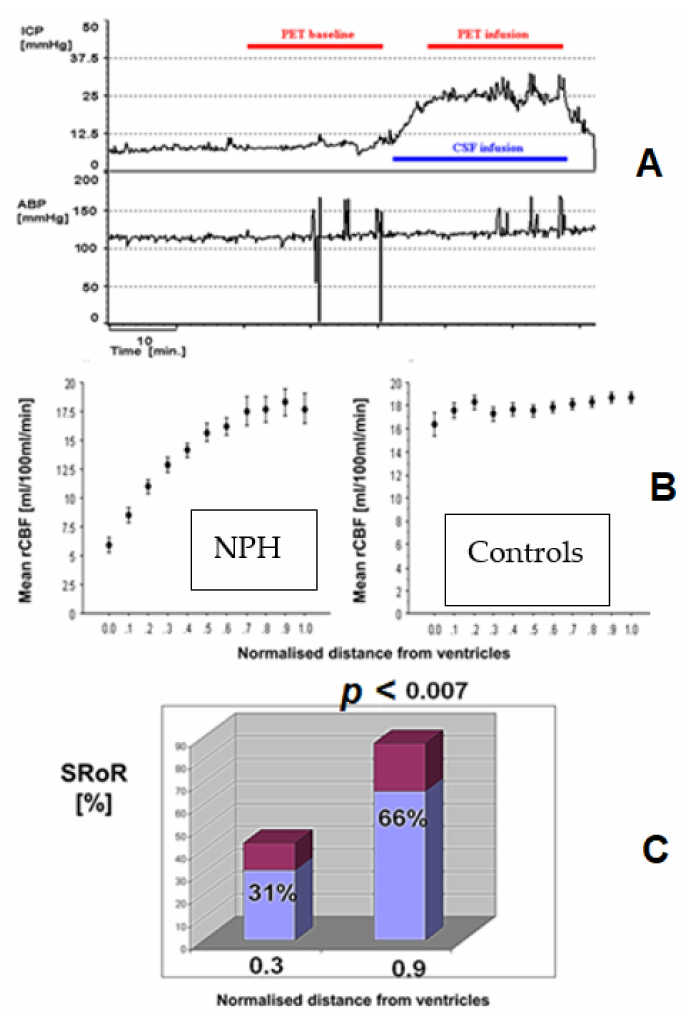
Figure 10. Regional cerebral blood flow and autoregulation in hydrocephalus: relationship with distance from ventricles. ( A ): Demonstration of methodology from our previous investigation of cerebral blood flow (CBF) using PET H2O whilst performing a simultaneous infusion test to monitor ICP. ( B ): PET study at baseline for recordings of CBF (before infusion test). The mean regional CBF (rCBF) in NPH ( left ) was significantly reduced in proximity to the ventricles compared to normal, aged-matched controls. ( C ): ICP monitoring allowed for calculation of the static rate of autoregulation (SRoR), which demonstrated that autoregulation of CBF is similarly significantly impaired in NPH at the regions in close relationship with the ventricles. SRoR is derived from the change in cerebral perfusion (Mean Arterial Blood pressure–ICP) and CBF during infusion. SRoR 100% indicates ideal autoregulation and 0% absent autoregulation. ABP: Mean arterial blood